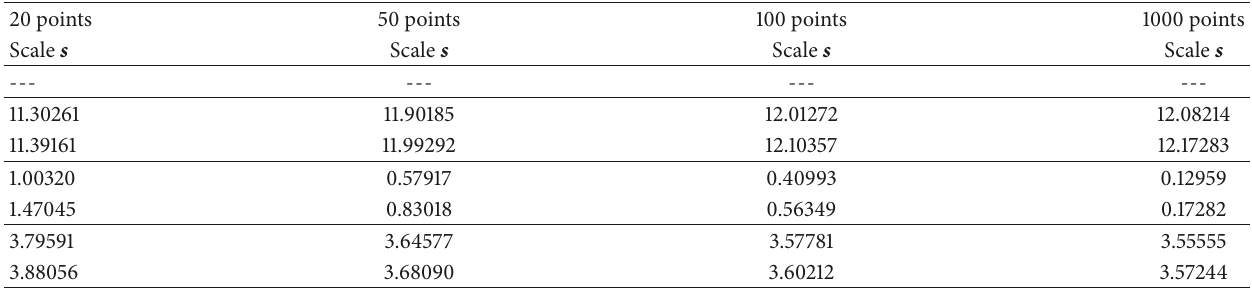
Table 51: Contaminated 𝜒 2 distributions with 50% noise level.